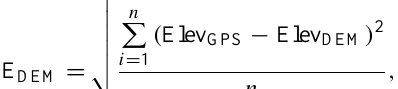
ground points taken at random positions within the